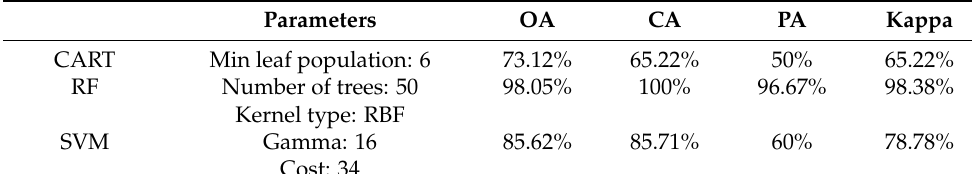
Table 3. Statistics of optimal parameters and accuracy of various algorithms. OA: overall accuracy;